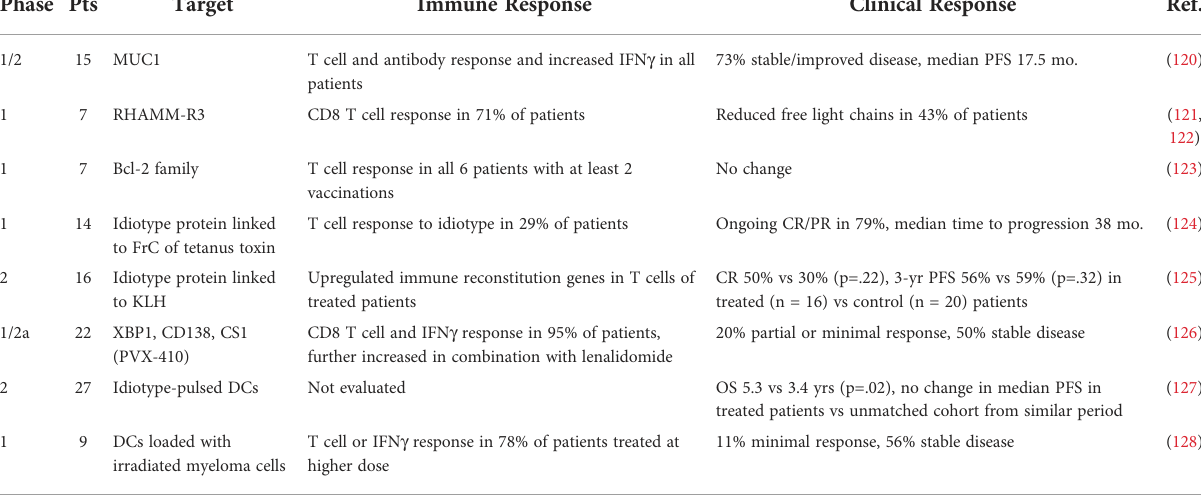
TABLE 2 Selected clinical trials of peptide or pulsed/loaded dendritic cell vaccines in myeloma. Phase